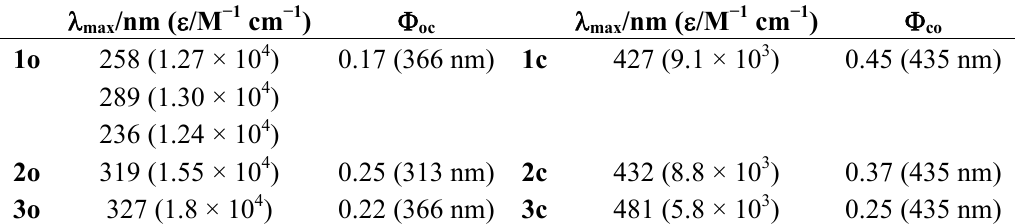
Table 1. Spectrocopic properties of bis(2-thienyl)perfluorocyclopentenes in hexane solution.